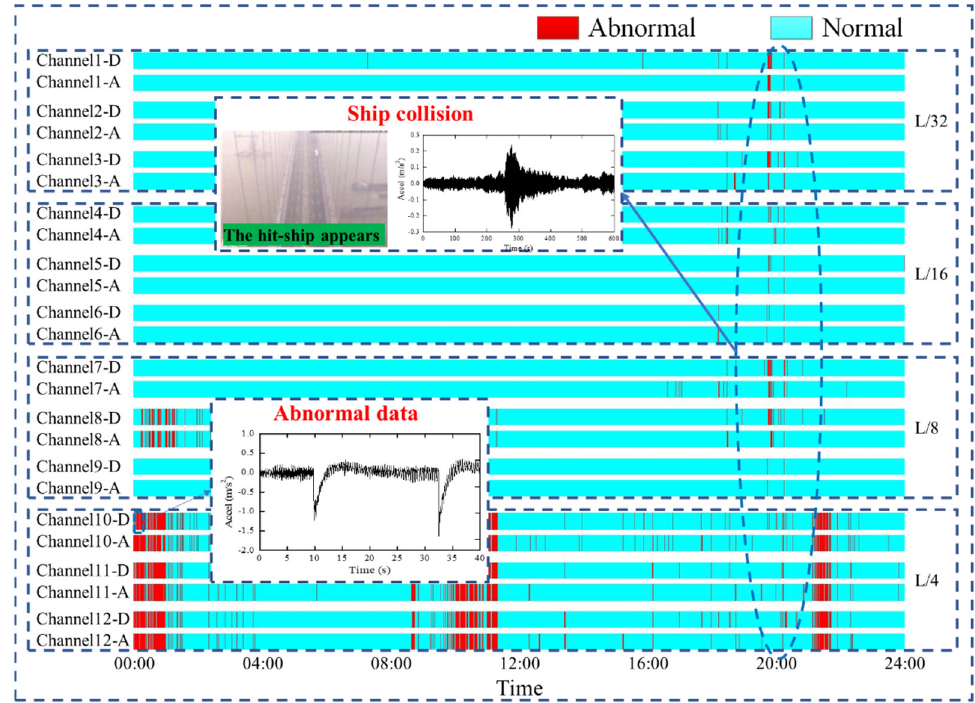
Figure 13. The detection results of SHM data (-A symbolizes the results with human labeled, -D symbolizes the detected results). Table 5. The ADA of 12